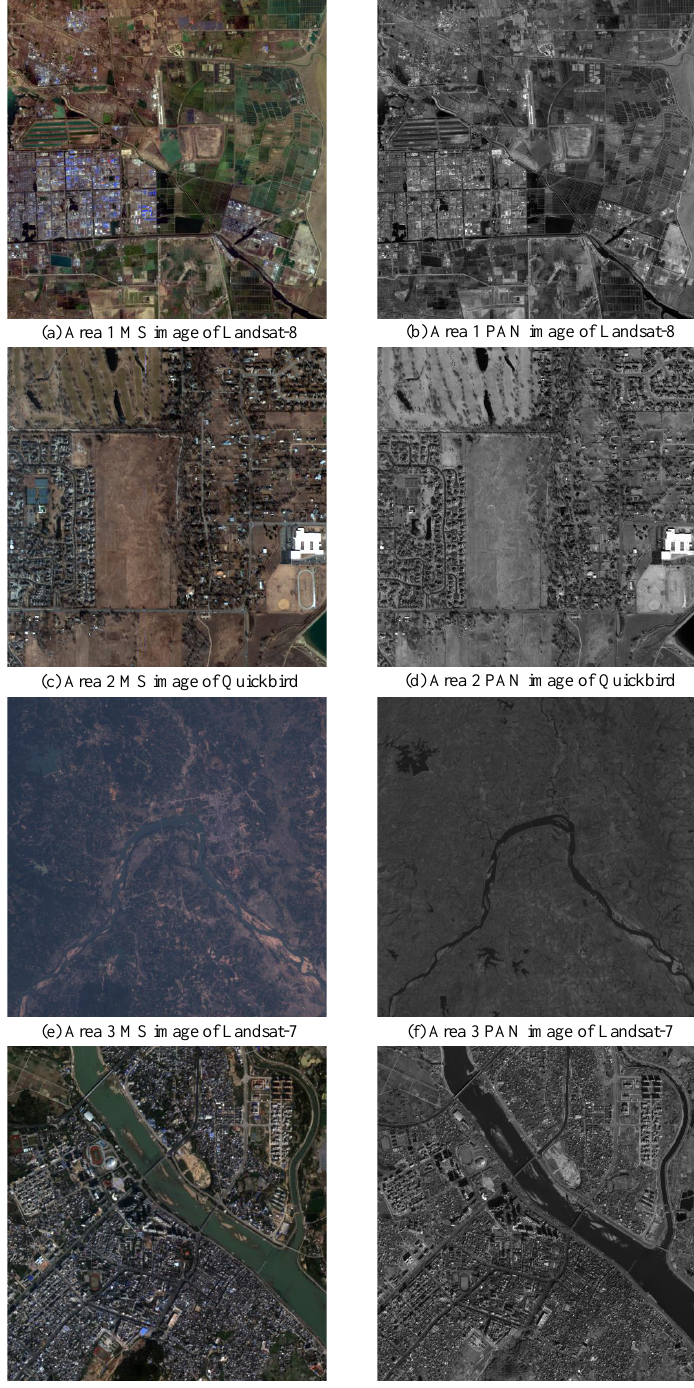
Figure 10. Testing datasets of four different satellites: ( a ) Area 1 MS image with 30-m resolution of Landsat-8. ( b ) Area 1 PAN image with 15-m resolution of Landsat-8. ( c ) Area 2 MS image with 2.8-m resolution of QuickBird. ( d ) Area 2 PAN image with 0.7-m resolution of QuickBird. ( e ) Area 3 MS image with 30-m resolution of Landsat-7. ( f ) Area 3 PAN image with 15-m resolution of Landsat-7. ( g ) Area 4 MS image with 4-m resolution of GF-2. ( h ) Area 4 PAN image with 1-m resolution of